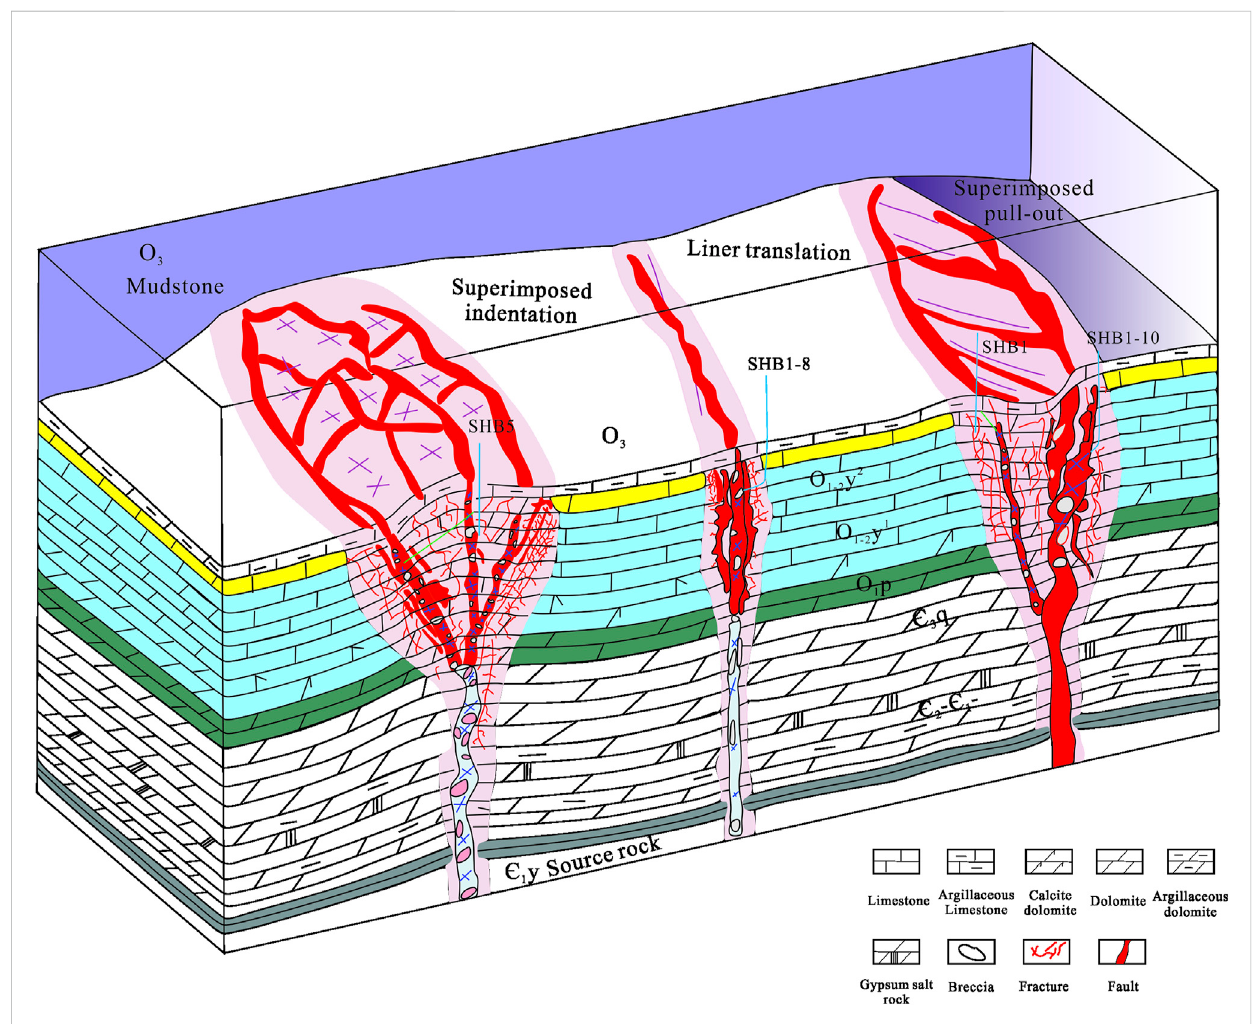
FIGURE 11 Oil and gas accumulation and enrichment patterns of different segments of strike slip fault zone in Shunbei Oil fi eld (Modi fi ed from Qi